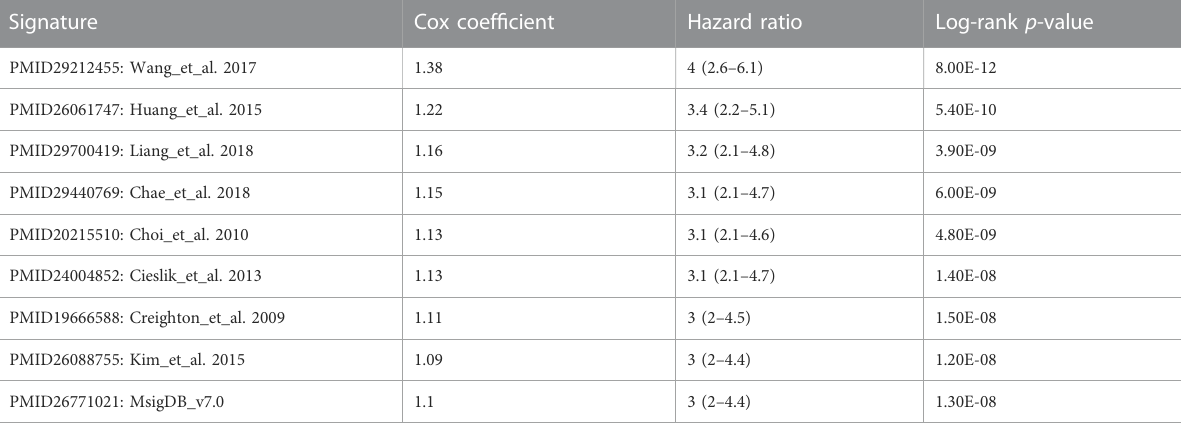
TABLE 1 Univariate Cox regression analysis for EMT gene sets by the EMTome